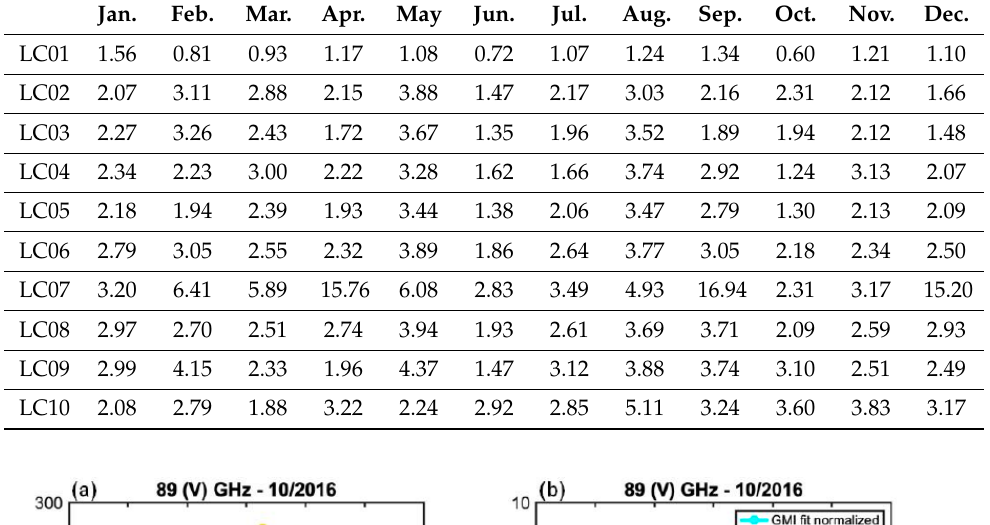
Table 1. Mean monthly differences between GMI and SSMIS/AMSR2 data for each land cover types at 23 GHz vertical polarization.